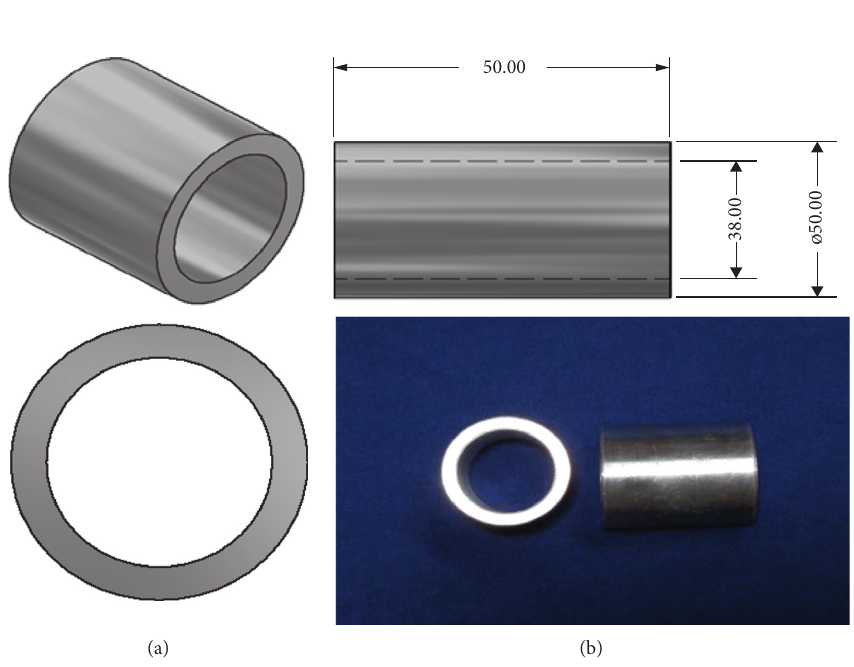
Figure 6: (a) Workpiece draft. (b) FSW (workpiece) component.